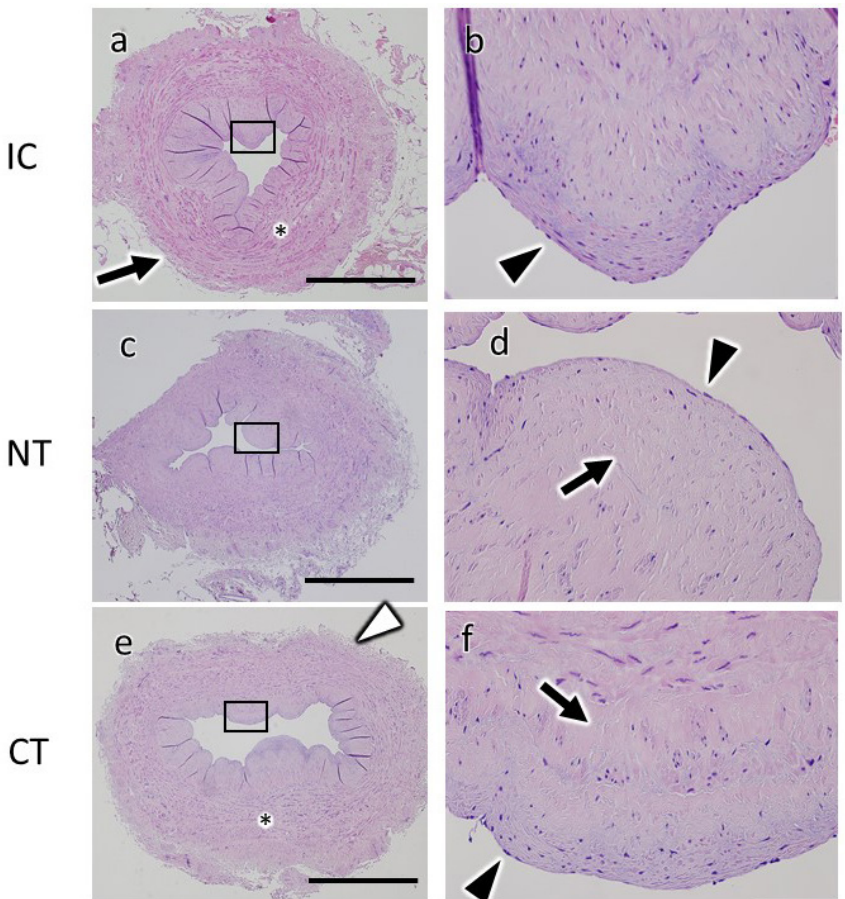
Fig. 2 - Light microscopy images. Light microscopy differences of the saphenous vein graft (SVG) between the two harvesting methods (no-touch [NT] and conventional [CT]) and intact control (IC). Light microscopy images of paraffin SVG sections prepared for the IC (a, b), NT SVG (c, d), or CT SVG (e, f) and stained with hematoxylin-eosin were acquired at low (a, c, e) and high (b, d, f) magnification. Areas marked with rectangles (a, c, e) are magnified (b, d, f). In IC (a, b), endothelial cells (b, arrowhead) and adventitia (a, arrow) were well preserved, and vascular smooth muscle (a, asterisk) was thick. In NT (c, d), most endothelial cells (d, arrowhead) were preserved, and the intima and subendothelial structures showed slight edematous changes (d, arrow). In CT (e), loss of endothelial nuclei was not obvious (f, arrowhead), and the intima and subendothelial structures showed edematous changes (f, arrow). The tunica media and smooth muscle were stretched (e, asterisk), and the adventitia was detached (e, white arrowhead). Scale bars: 1 mm. Perivascular fat tissue of NT was removed before